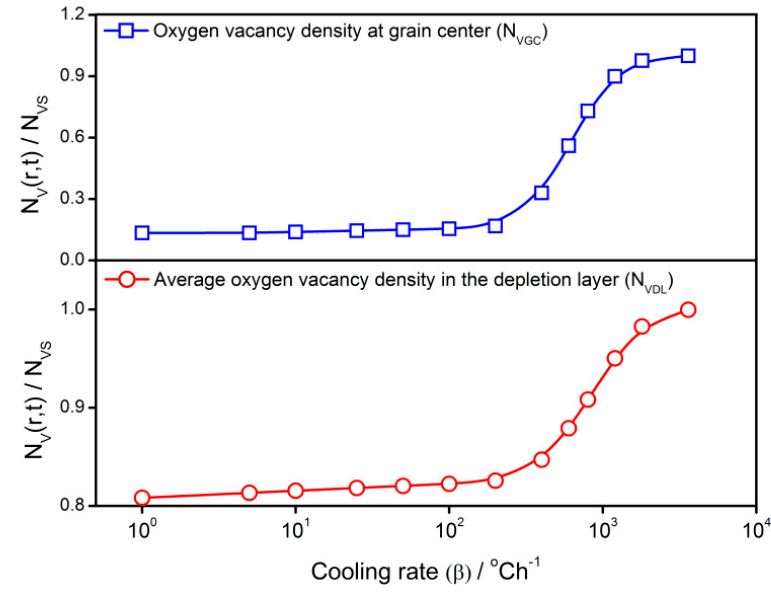
Figure 6. Influence of cooling rate on steady state oxygen vacancy density at the grain center ( N VGC ) and the average oxygen vacancy density in the depletion layer ( N VDL ) of a 25 nm grain.